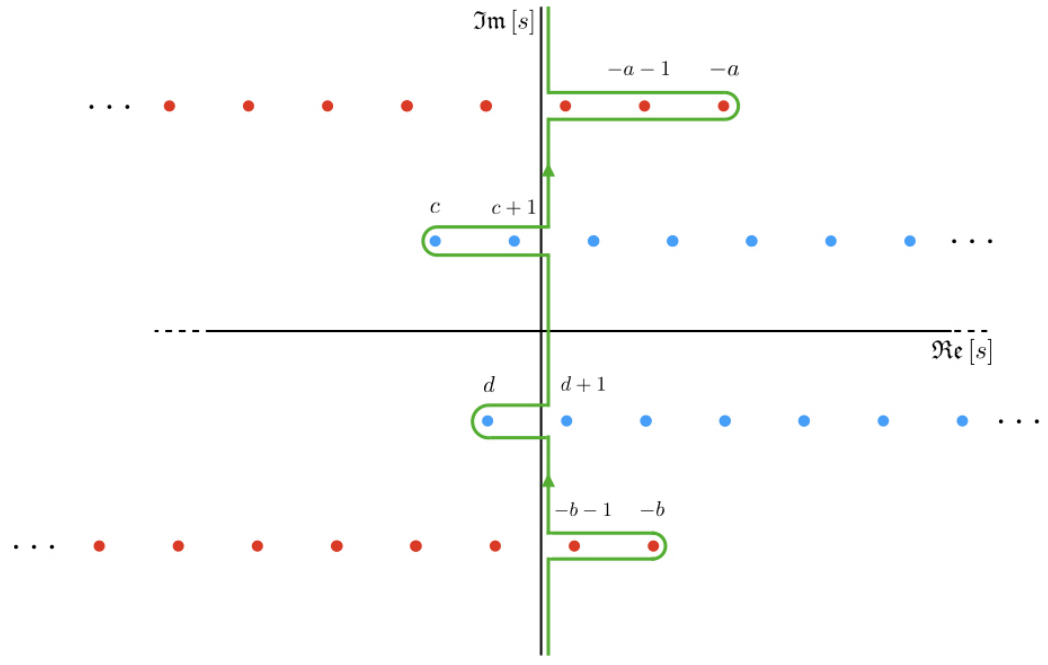
Figure 9. Integration contour (Green) for the Mellin-Barnes integral (A.2). This is chosen to separate the poles of the (cid:0) functions (cid:0) ( a + s ) and (cid:0) ( b + s ) (the red dots) which extend along the negative real axis from the sequences of poles of (cid:0) ( c (cid:0) s ) and (cid:0) ( d (cid:0) s ) (the blue dots) which extend along the positive real